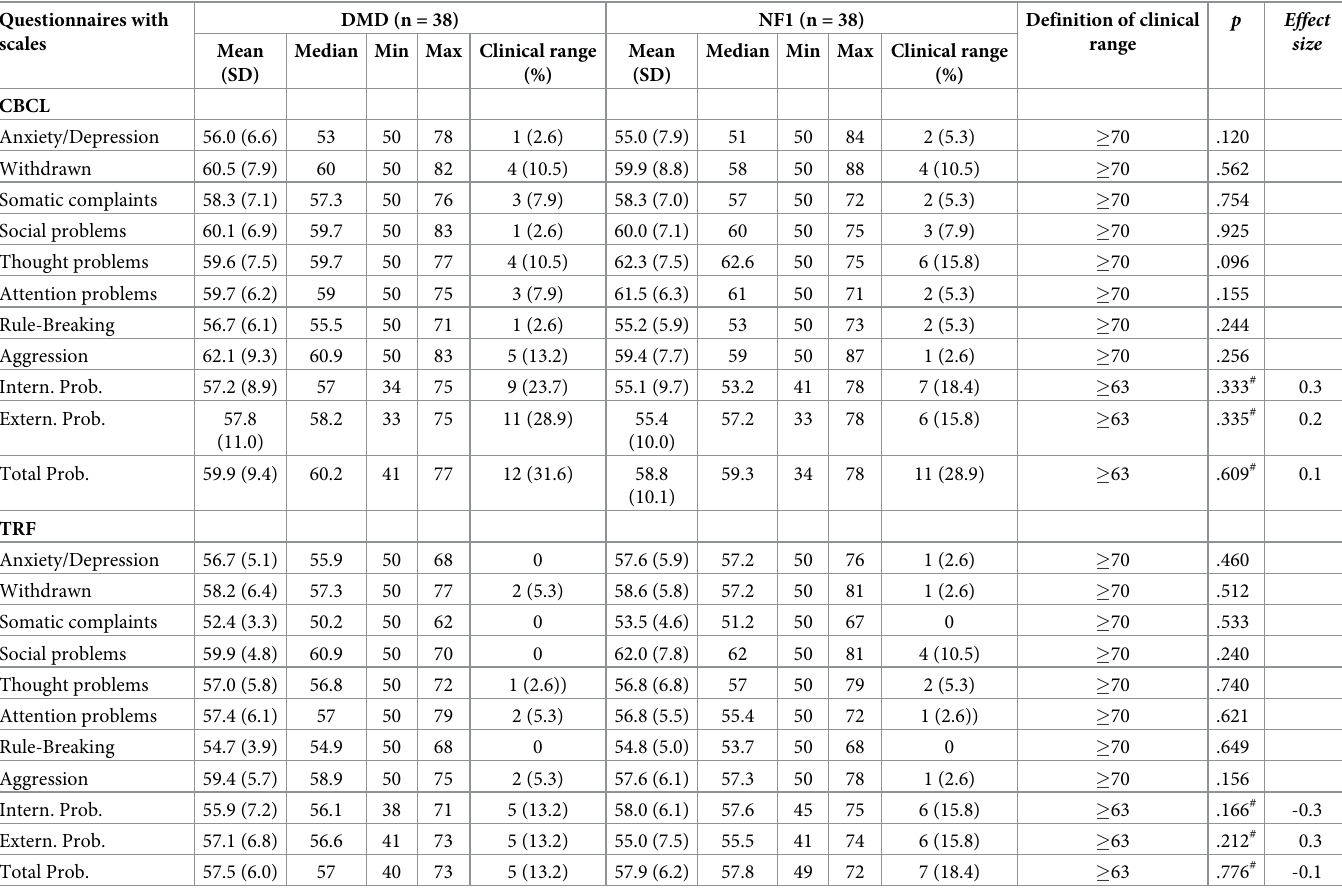
Table 5. Behavioral reports of parents and teachers of the DMD and NF1 group. Questionnaires with